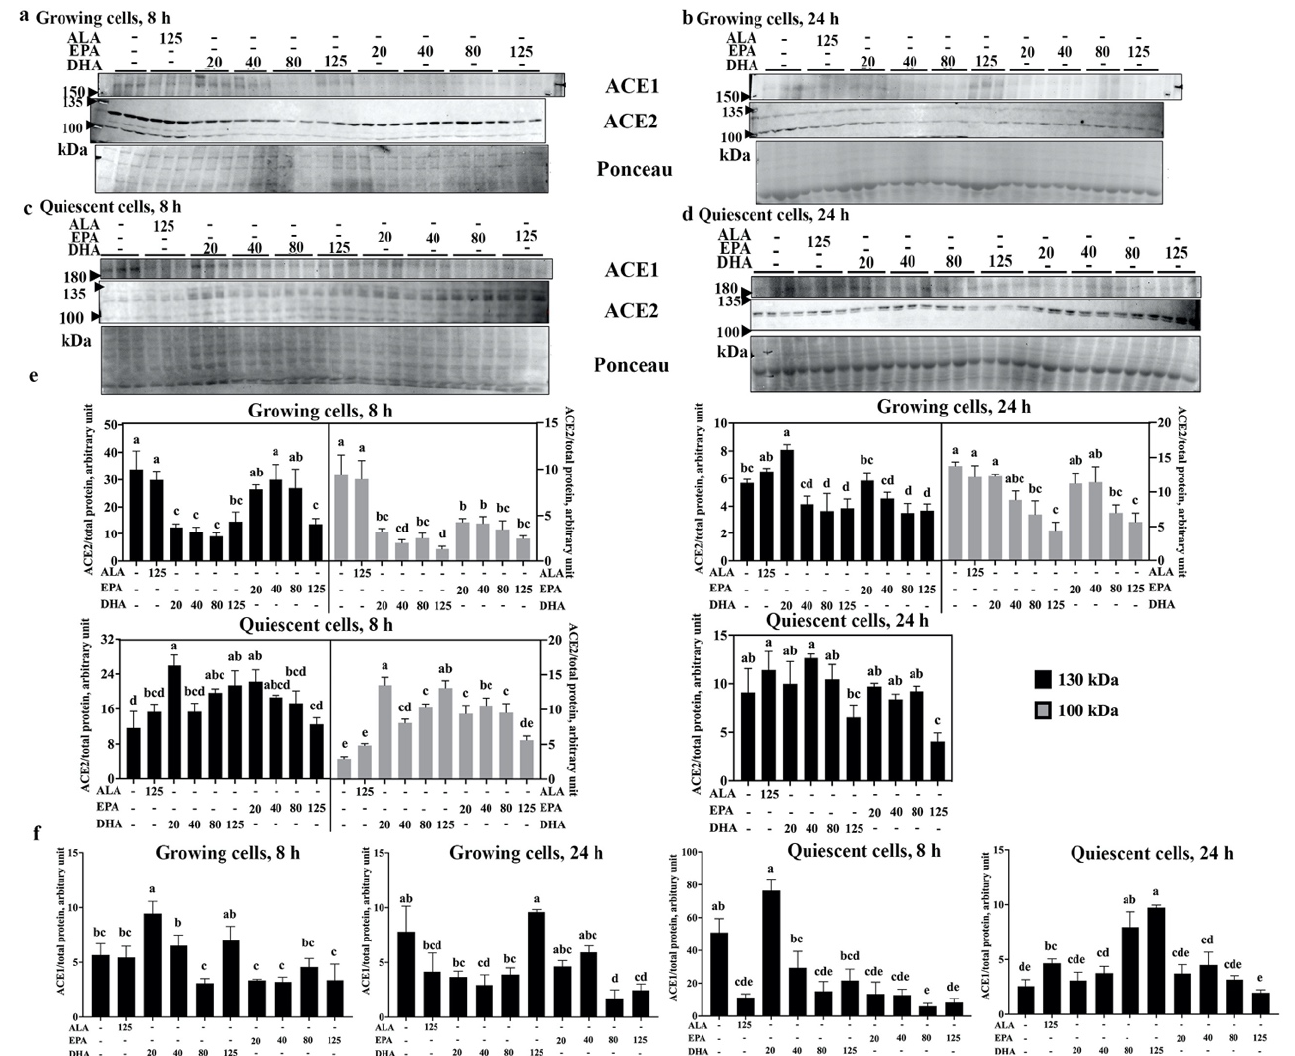
Figure 2. DHA differentially modulates ACE1 and ACE2 levels in growing and quiescent EA.hy926 endothelial cells. Western blotting was used to compare ACE1 and ACE2 relative to total protein load, as measured by Ponceau S in growing cells treated with ALA, EPA, or DHA at the indicated concentrations (µM) for ( a ) 8 and ( b ) 24 h, as well as in quiescent cells treated with n3-PUFA for ( c ) 8 and ( d ) 24 h. The band intensities of ACE2 and ACE1 were quantified and are graphically presented in panels ( e , f ), respectively; the 100 kDa band (grey bars) represents non-glycosylated ACE2, whereas the 130 kDa band (black bars) corresponds to N -glycosylated ACE2. Data are presented as mean ± SEM, n = 3; bars not sharing a common letter in the graphs are significantly different ( p < 0.05) based on Duncan’s multiple range or LSD post-hoc